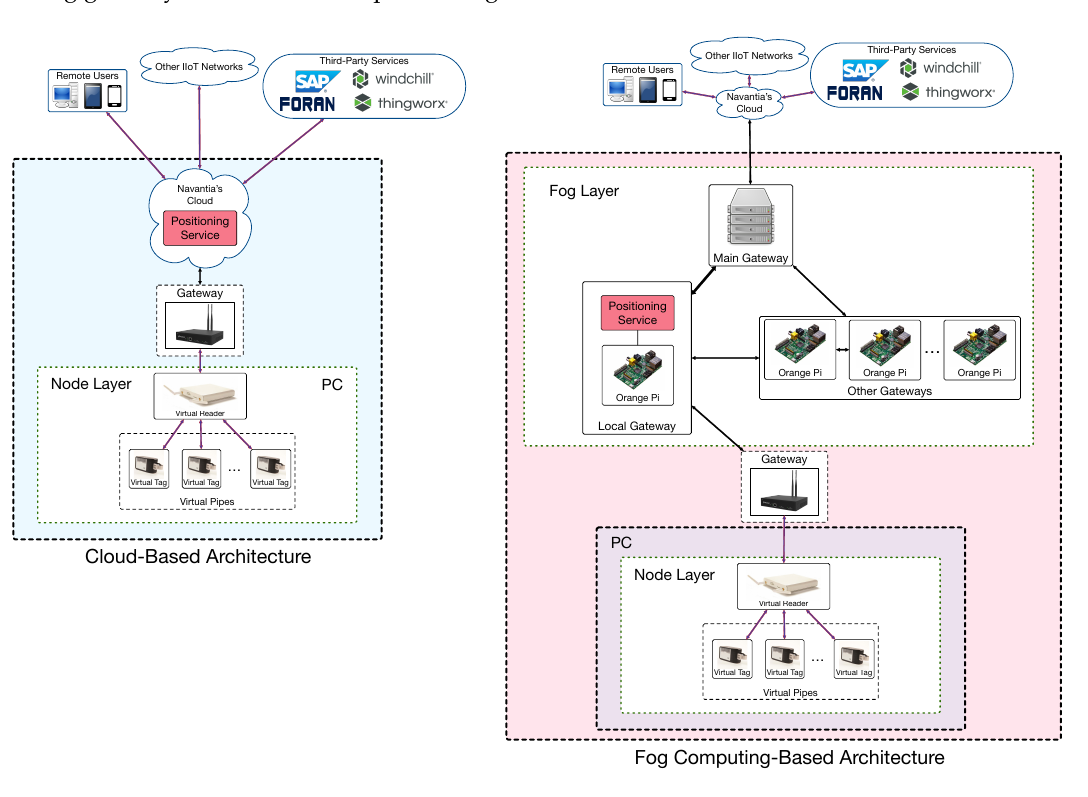
Figure 17. Implemented